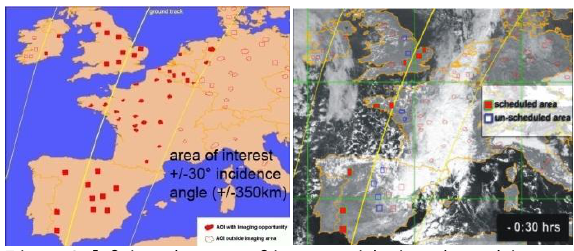
Figure 8. left in red = area of interest, right in red = tasking area dependent upon cloud coverage, satellite slewing speed and imaging capacity (Zevenbergen